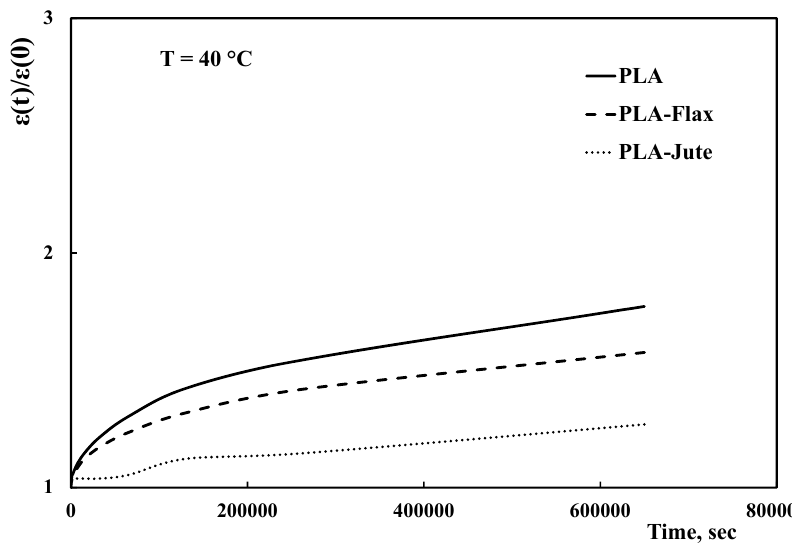
Figure 4. Normalized deformation versus time trends of PLA and related composites at 40 °C.